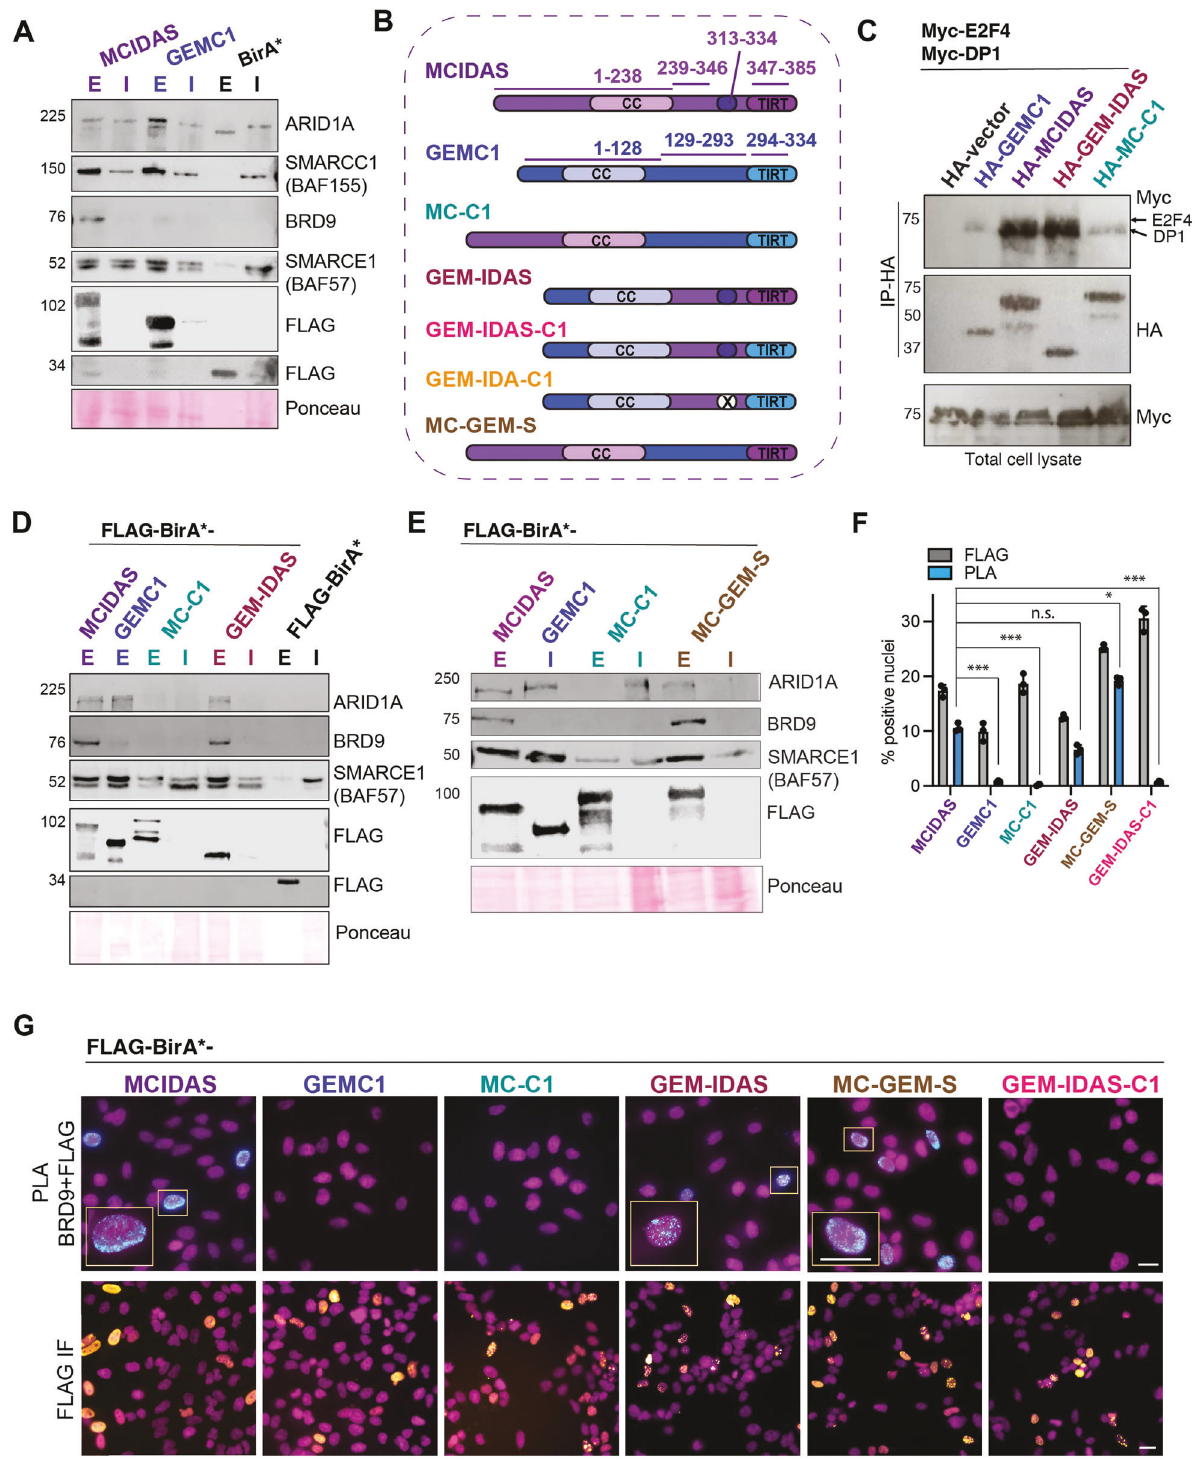
performed immunoprecipitations for GEMC1, MCIDAS, GEM-IDAS, and MC-C1 using an HA-tag. As predicted, GEM-IDAS, containing